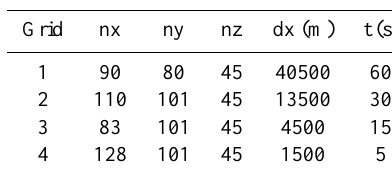
Table 2. Rams model settings